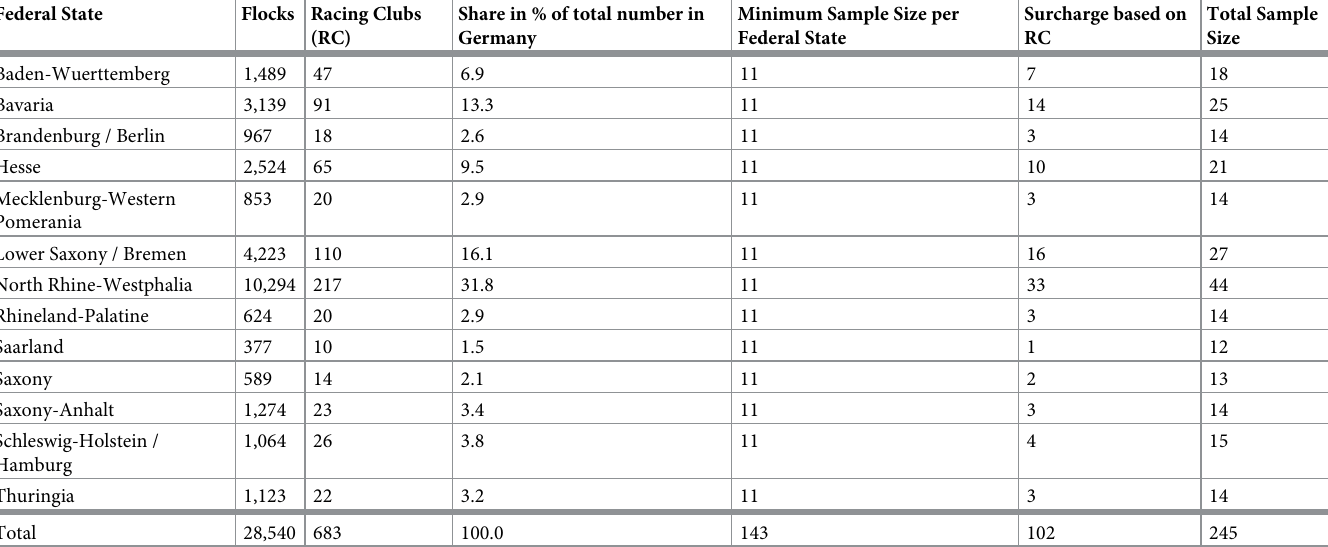
Table 1. Sampling design for the determination of flock prevalence in racing